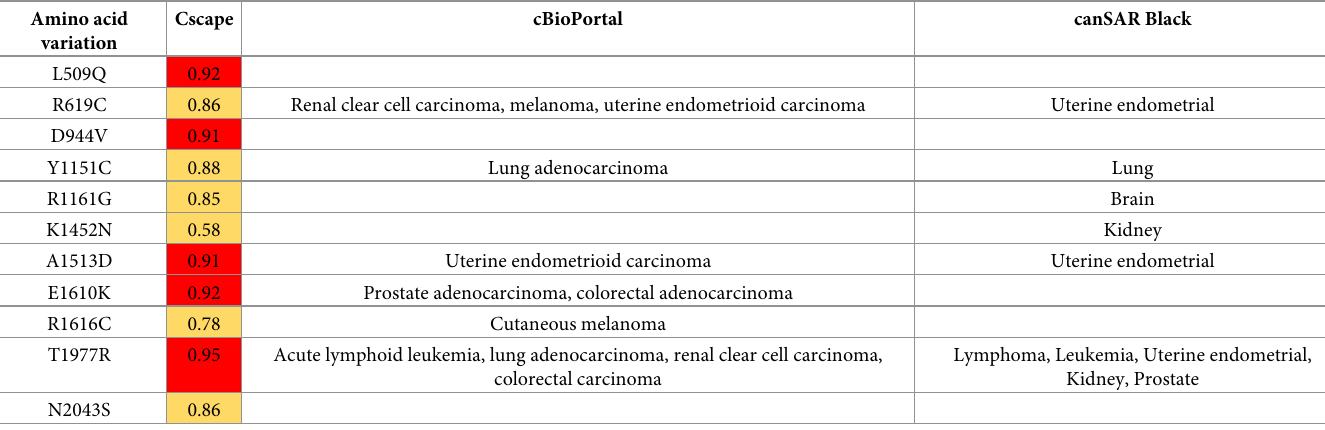
Table 4. Association study of the high-risk nsSNPs with different types of cancer obtained from Cscape, cBioPortal and canSAR Black databases. Amino acid Cscape variation